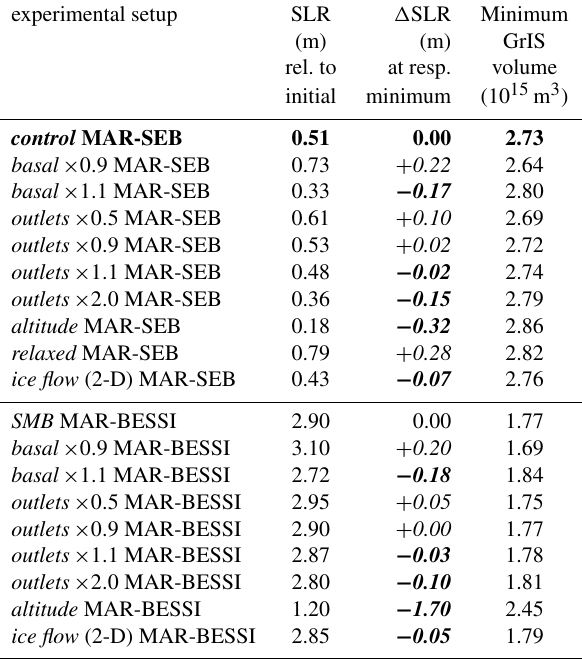
Table 3. Summary of the simulated ice sheet minima for all experi-